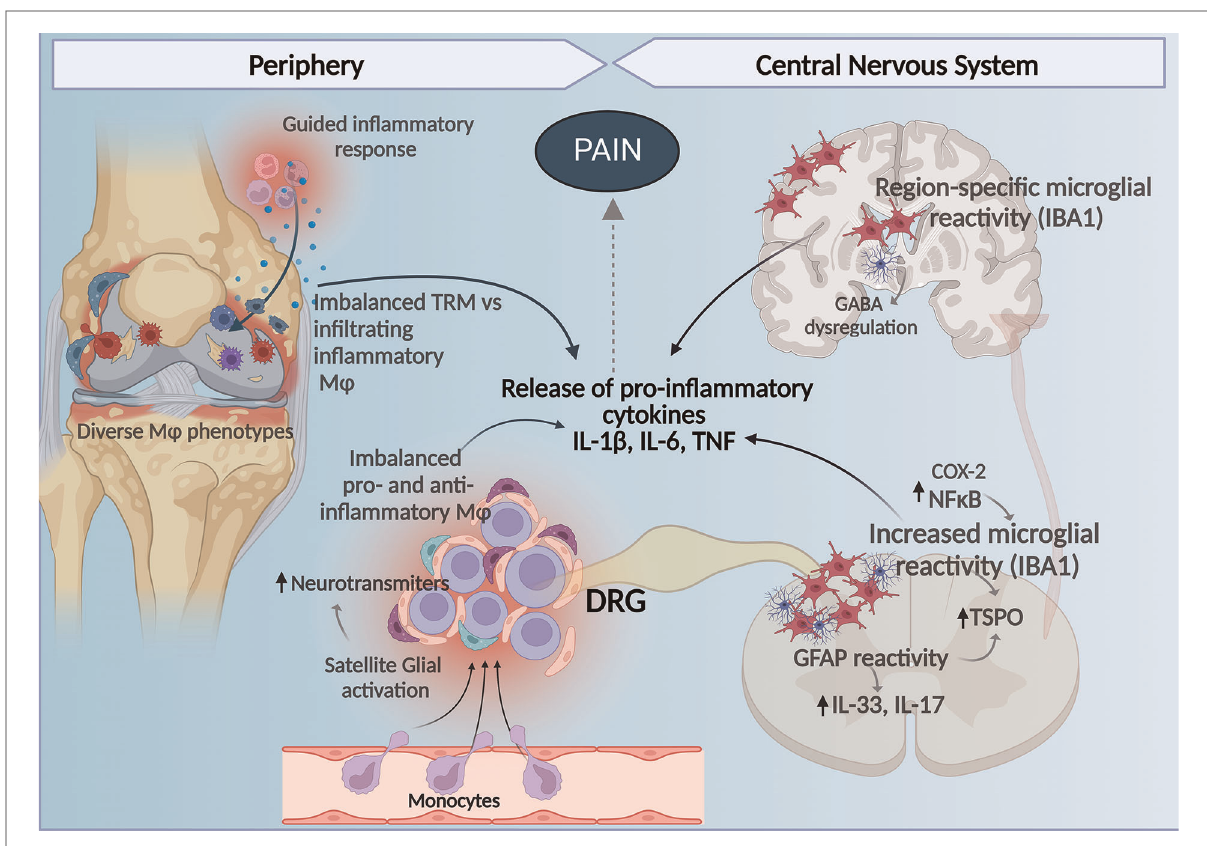
FIGURE 1 Central and peripheral mechanisms involving macrophages and glial cells contribute to the development of pain in RA. Imbalance between homeostatic TRM and in fi ltrating macrophages with pro-in fl ammatory pro fi les to the synovial tissue contribute to the in fl ammatory milieu perpetuating in fl ammation, tissue damage, and bone remodeling affecting nociceptors in the joint. In the DRG, increased proin fl ammatory macrophages and reduced anti-in fl ammatory homeostatic/resident-like macrophages contribute to release of pro-in fl ammatory cytokines and together with satellite glia-induced release of neuromodulation molecules there is an increase in DRG neuronal activity. At the spinal cord increased microglial and astrocyte reactivity also enhance production of pro-in fl ammatory cytokines and in the brain increased glial reactivity in a region-speci fi c manner regulating cytokine release and GABA neurotransmitter tone affects pain perception in arthritis. Figure created with Biorender.com. M φ , macrophages; TMR, tissue-resident